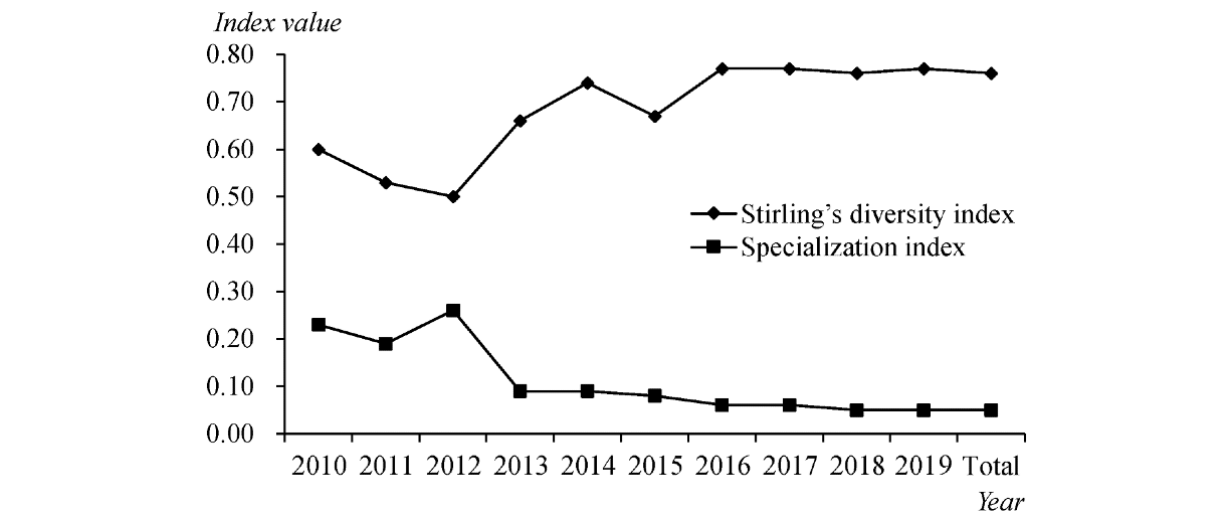
Figure 6. Stirling’s diversity index and the specialization index over time.